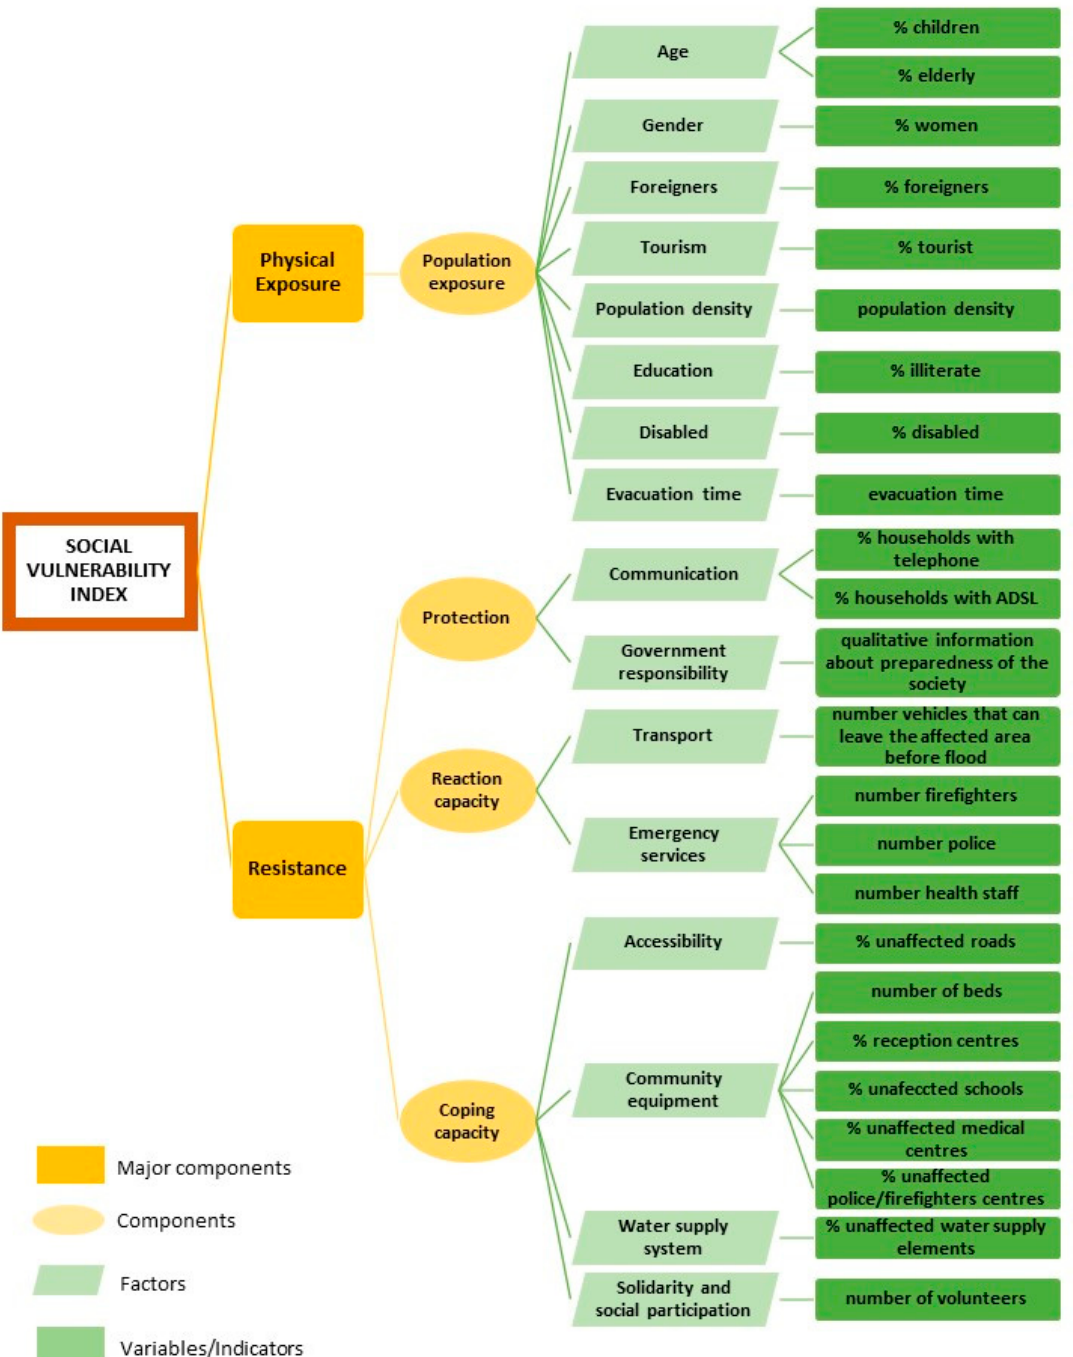
Figure 3. Relationships among the elements of the proposed vulnerability